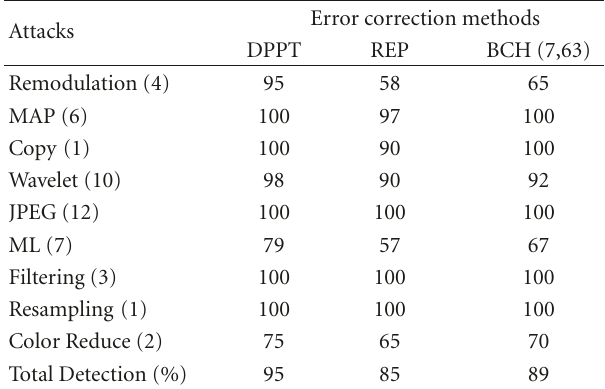
Table 6: Performance comparison of the fec-based postprocessing schemes and DPPT-based technique under checkmark benchmark attacks [70] for 10